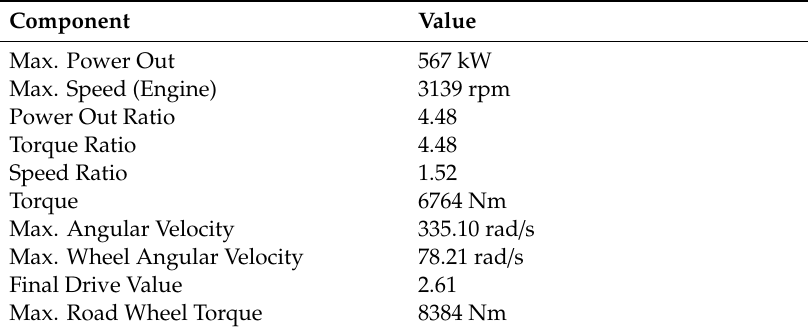
Table 2. Modified preliminary prime mover and final drive